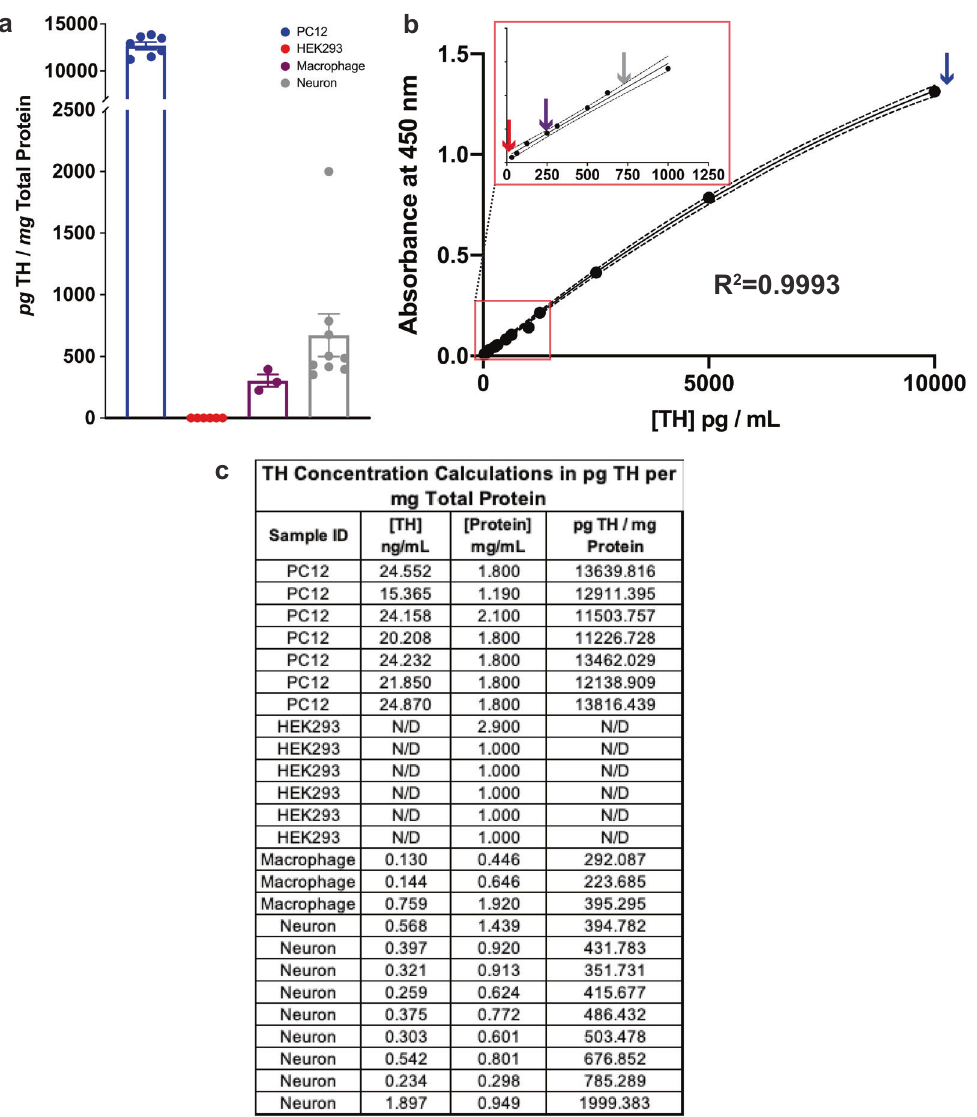
Fig. 3 Bio-ELISA reliably quanti fi es TH in PC12 cells, human macrophages and cultured murine dopamine neurons. a Using the Bio-ELISA shown in Fig. 1g, we quanti fi ed TH in four relevant tissues and cultured cells: PC12 (positive control), HEK293 (negative control), cultured human macrophages and cultured primary murine dopamine neurons. PC12 cells express very high levels of TH (<10 ng TH/mg total protein) relative to human macrophages (~300 pg TH/mg total protein) and primary murine dopamine neurons (~700 pg TH/mg total protein). b TH values are plotted on a representative standard curve for visual comparison, with an inset magnifying the lower end of the standard curve. c Calculations are shown by which raw TH concentration in ng/mL is normalized to total protein per sample. Samples included in a , each an independent biological replicate, are shown in c . Data are shown as